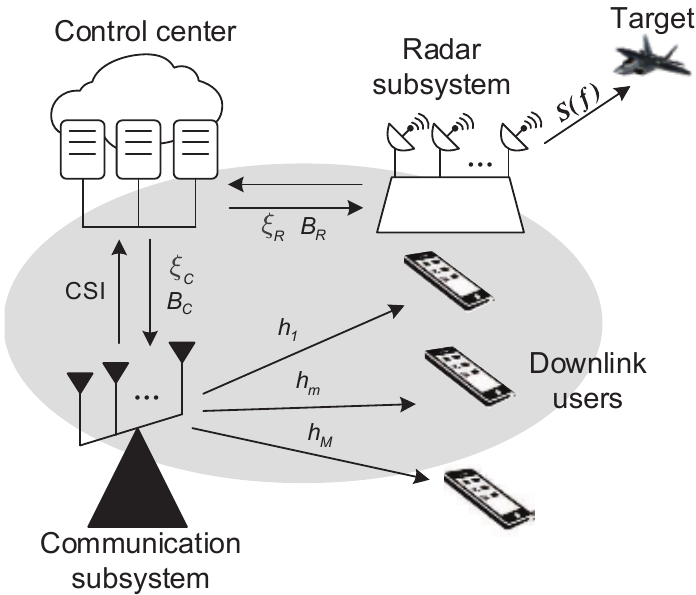
Figure 1. The proposed cooperative CRC system, including a control center, a radar subsystem, and a communication subsystem.